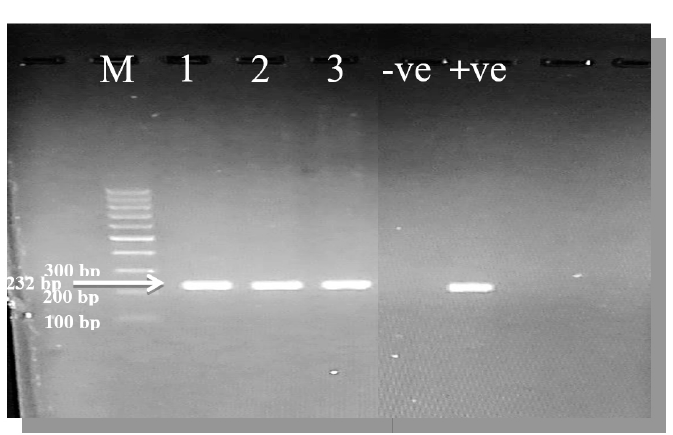
Fig. 5. PCR amplification products of Mycoplasma bovis gene on 2% agarose gel. M: Marker (100 – 1000 bp), samples (1 – 5): positive for M. bovis At 232 bp. molecular weight, +ve: Control positive for M. bovis , -ve: Control negative for M. bovis